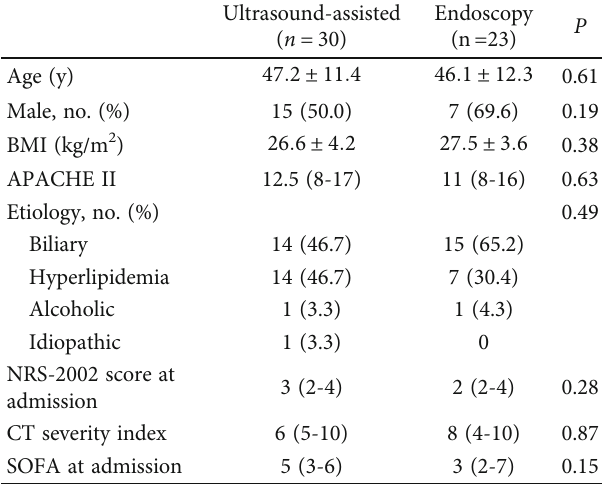
Table 1: Demographic and baseline characteristics.